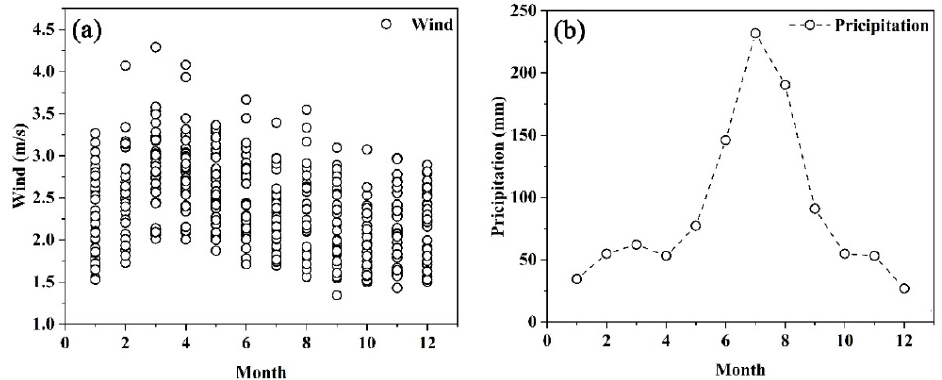
Figure 11. ( a , b ) Monthly changes in wind speed and precipitation.